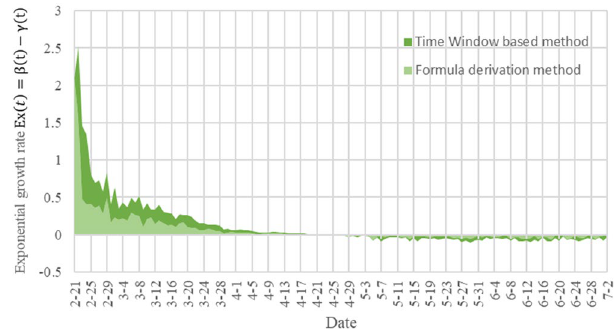
Figure 4. The result of the exponential growth rate Ex ( t ) in Italy from February 21 to July 2, 2020. (The dark green curve represents the measurement result of our proposed TW-SIR prediction model, and the light green curve is the formula-based method used in 22 ).